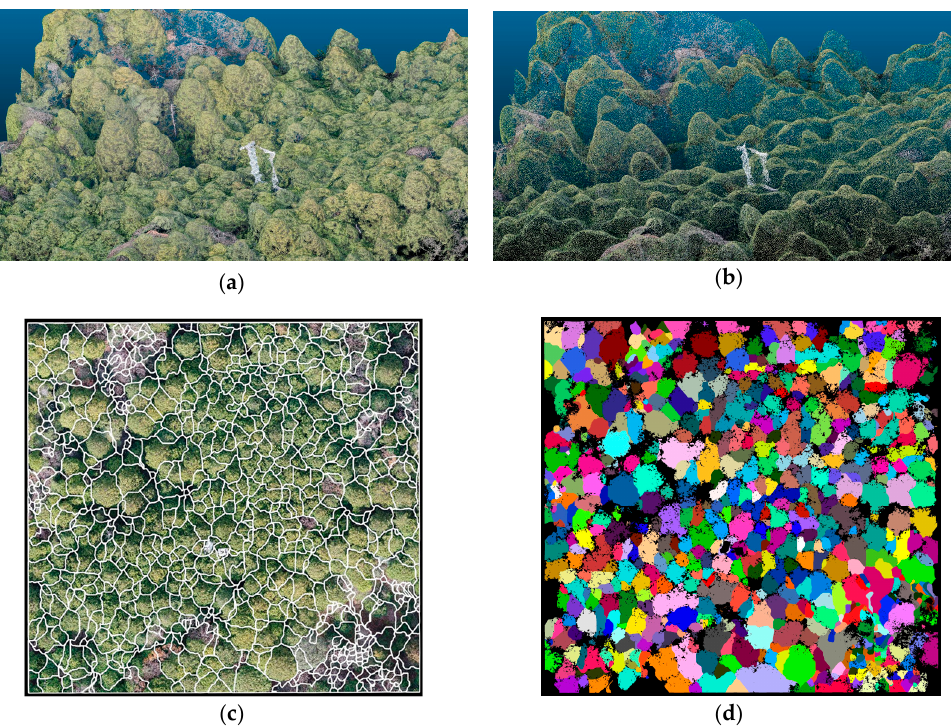
Figure 4. ( a ) Full dense point cloud of the study site and ( b ) smoothed point cloud processed with the moving least squares (MLS) method. ( c ) The polygons generated from the smoothed point cloud using the watershed segmentation, and ( d ) the final canopy shape from masking the canopy gaps and shadows. Random colors represent the canopy shapes, while black is the background (gap and shadows).